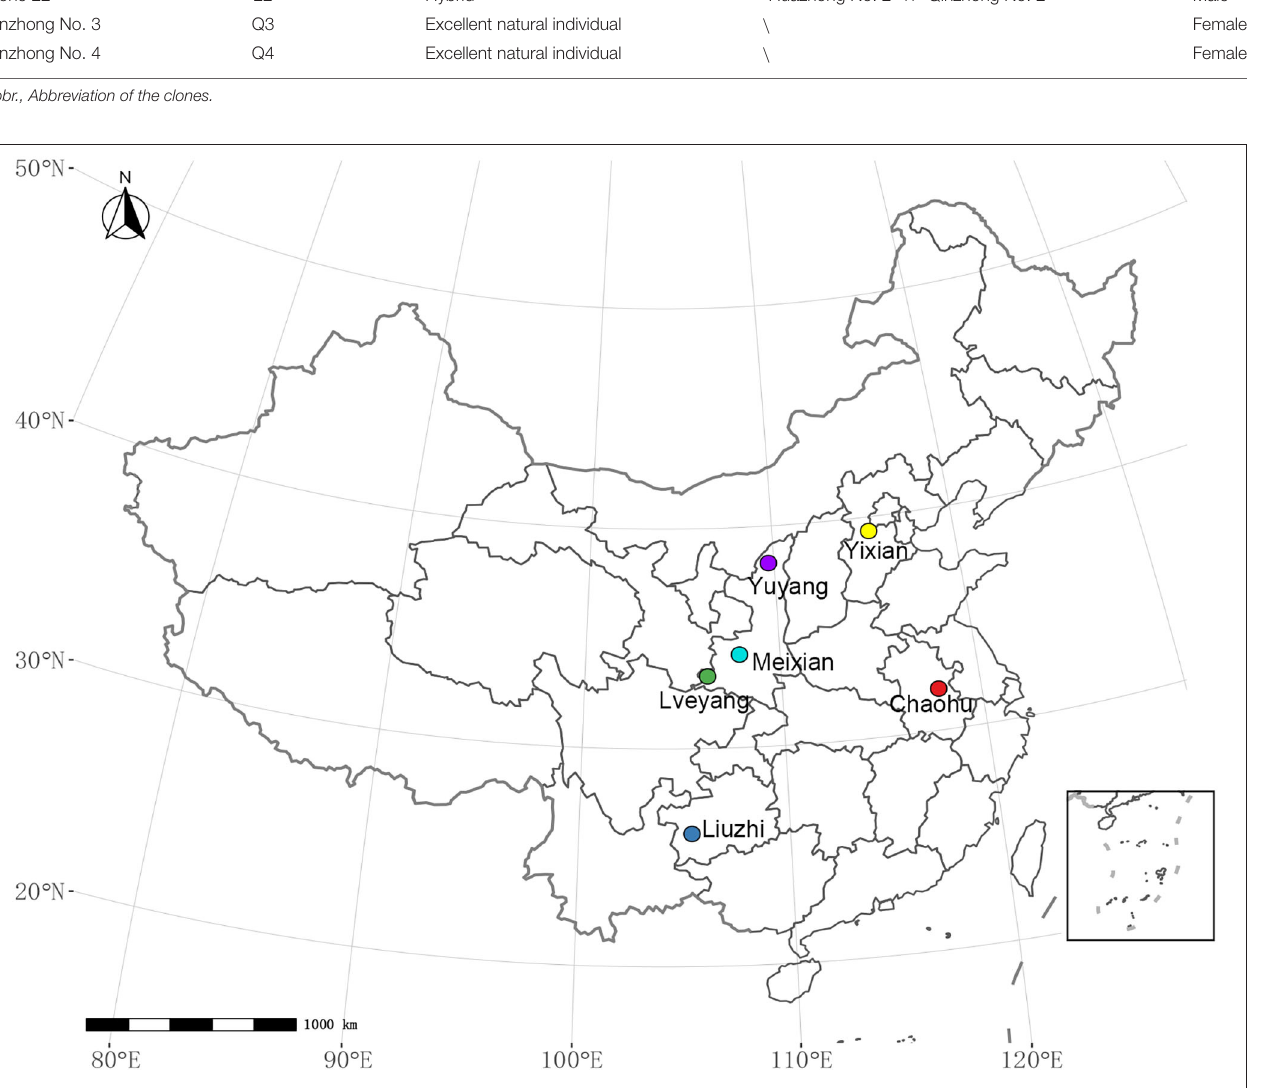
FIGURE 1 | Distribution of the experimental